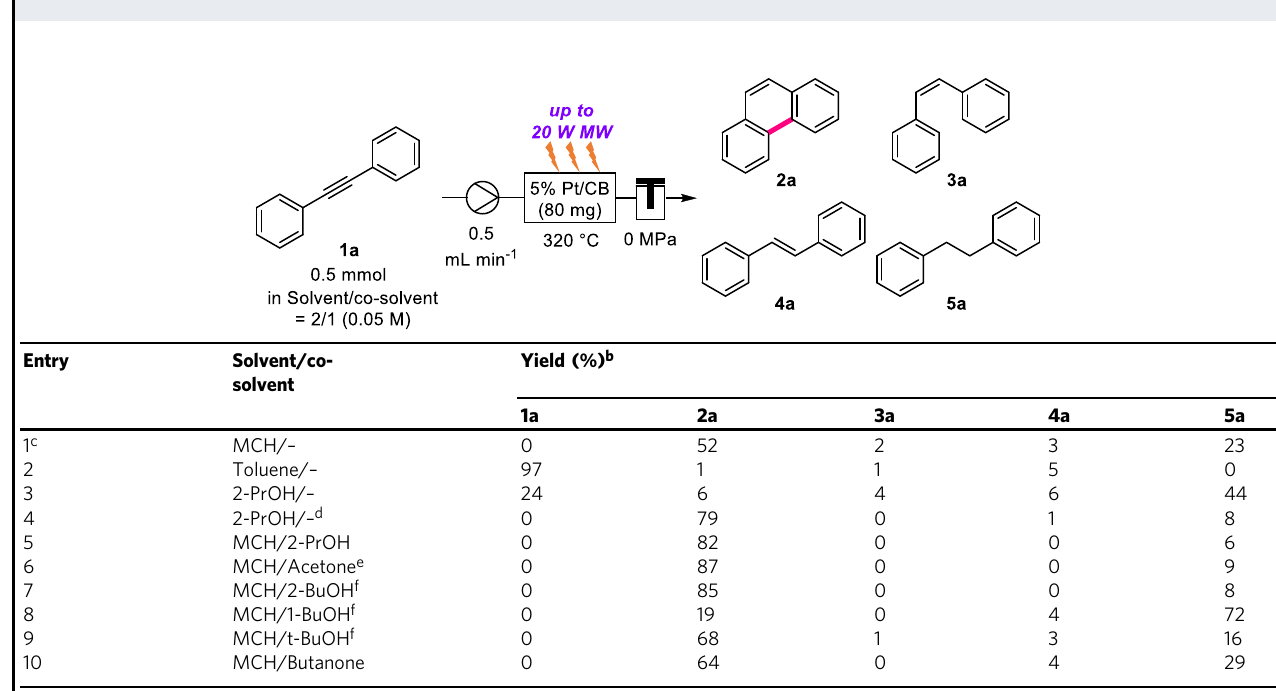
Table 2 Solvent and co-solvent effects a .